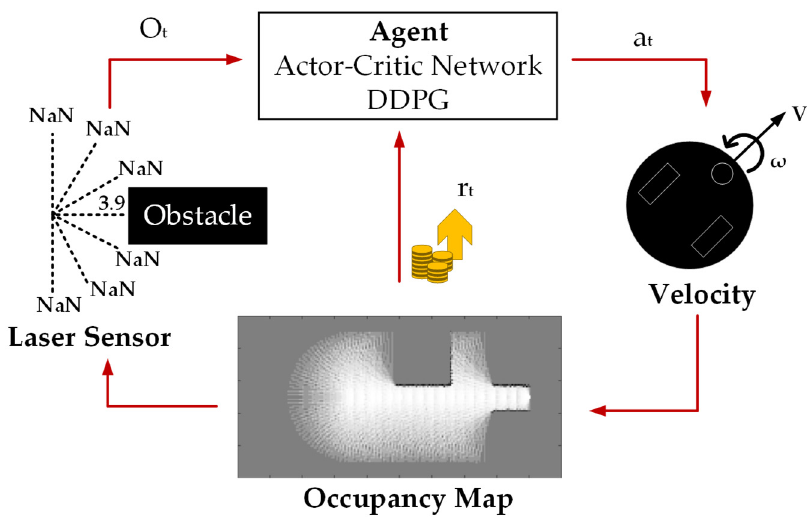
Figure 5. The MDP model of the mobile-robot exploration task.